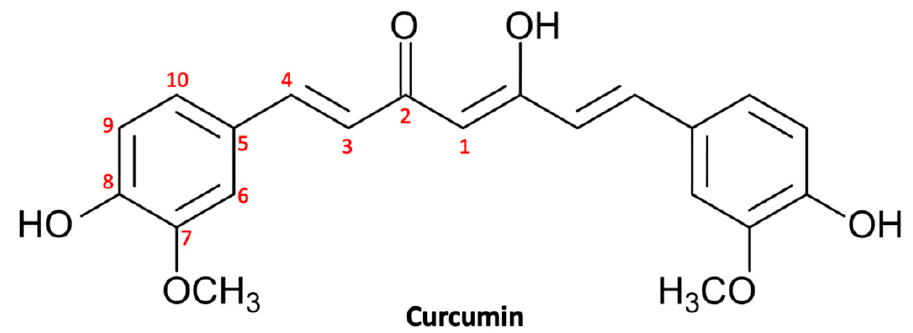
Figure 1. Molecular structure of curcumin.